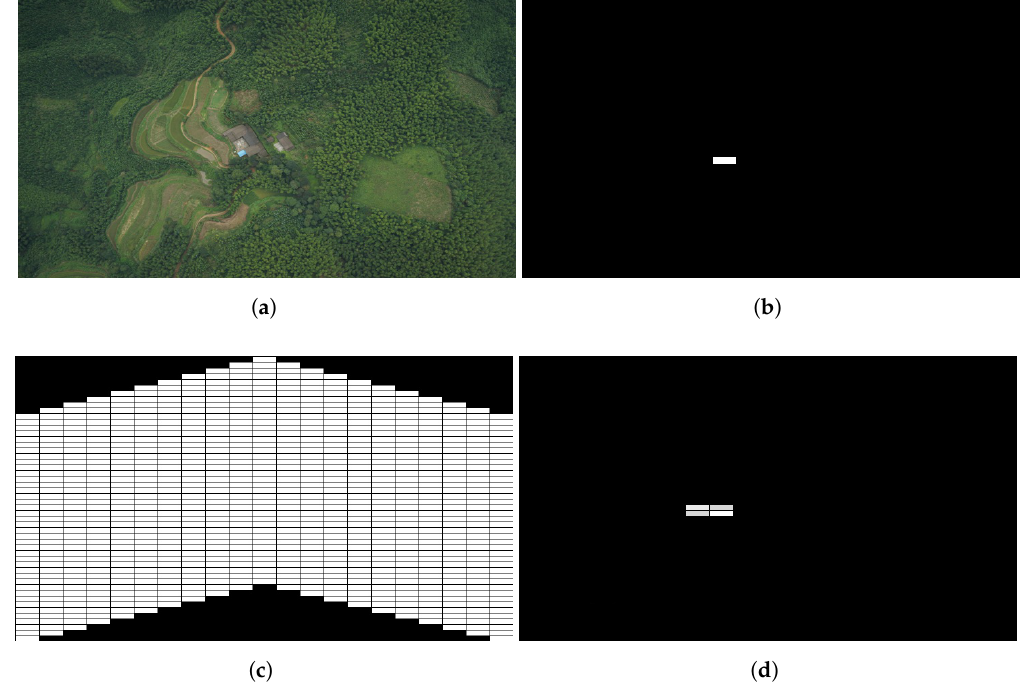
Figure 5. Simulated Distributed Salient Region Detection of Swarm Formations. ( a ) Original Scene; ( b ) Detection Result of Line Scan Case; ( c ) Coverage Area of V-Shape Scan Case; ( d ) Detection Result of V-Shape Scan